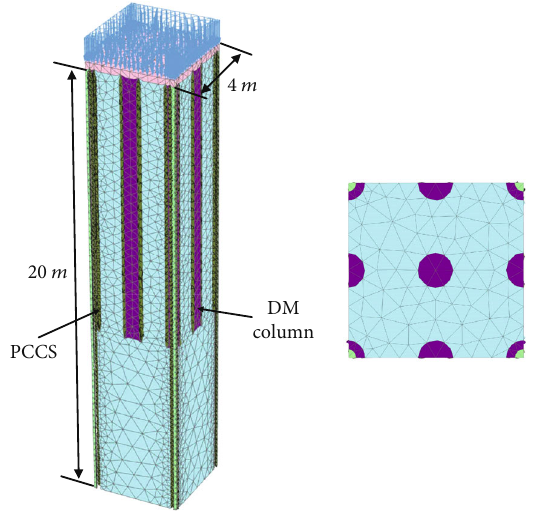
Figure 5: Finite element